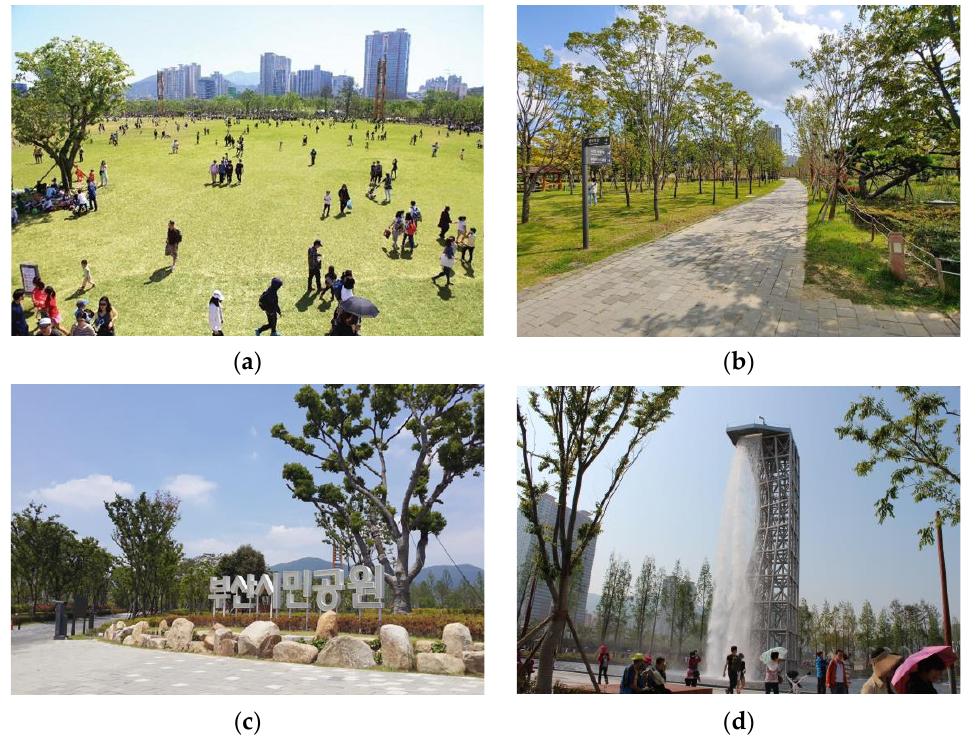
Figure 2. ( a ) The lawn plaza on weekends. ( b ) General paving condition of the park. ( c ) The south gate of the park. ( d ) A water feature of the mirror pond of the park.